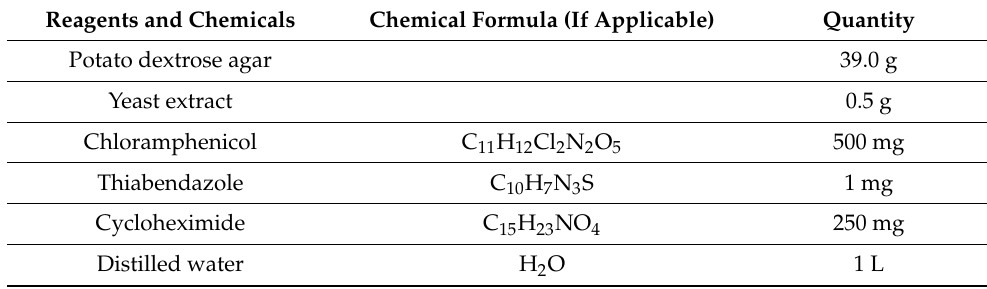
(14) Oatmeal Dodine agar (ODA). Reagents and Chemicals